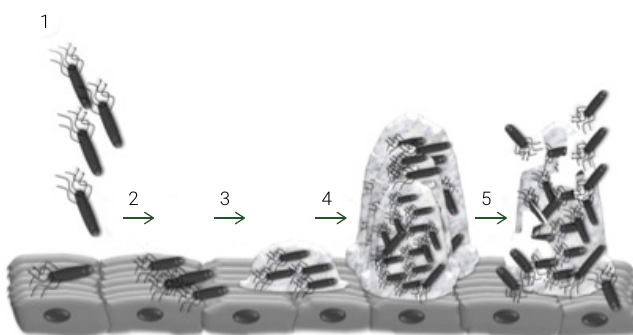
Figure 1. Stages in Biofilm Formation 10